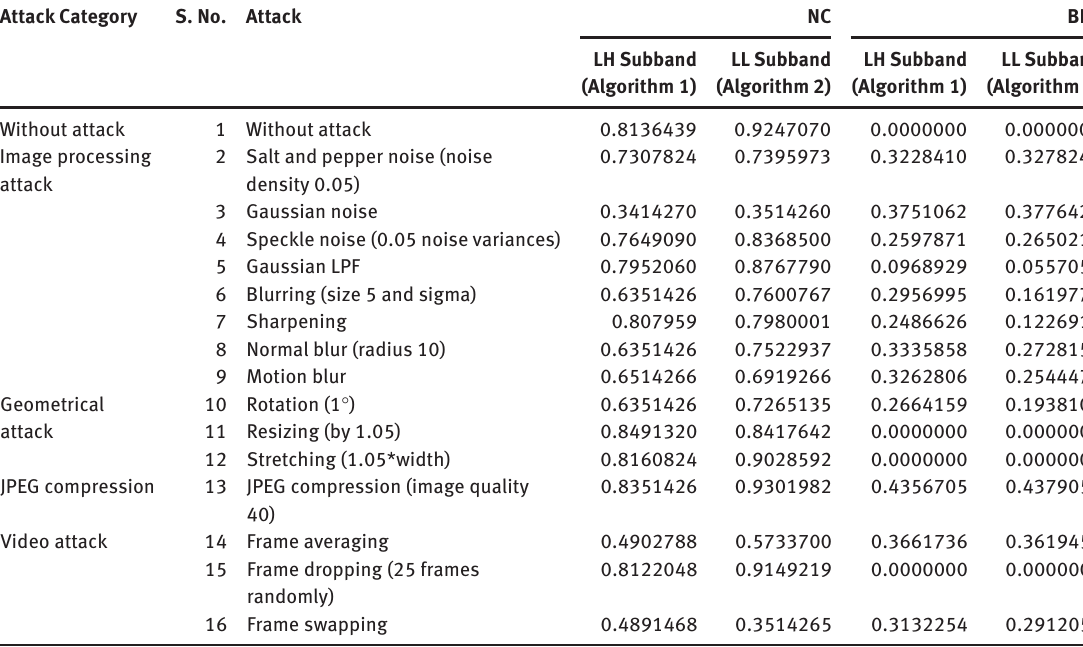
Table 4: Comparative Analysis between Watermarking Using the LL and LH Subbands. Attack